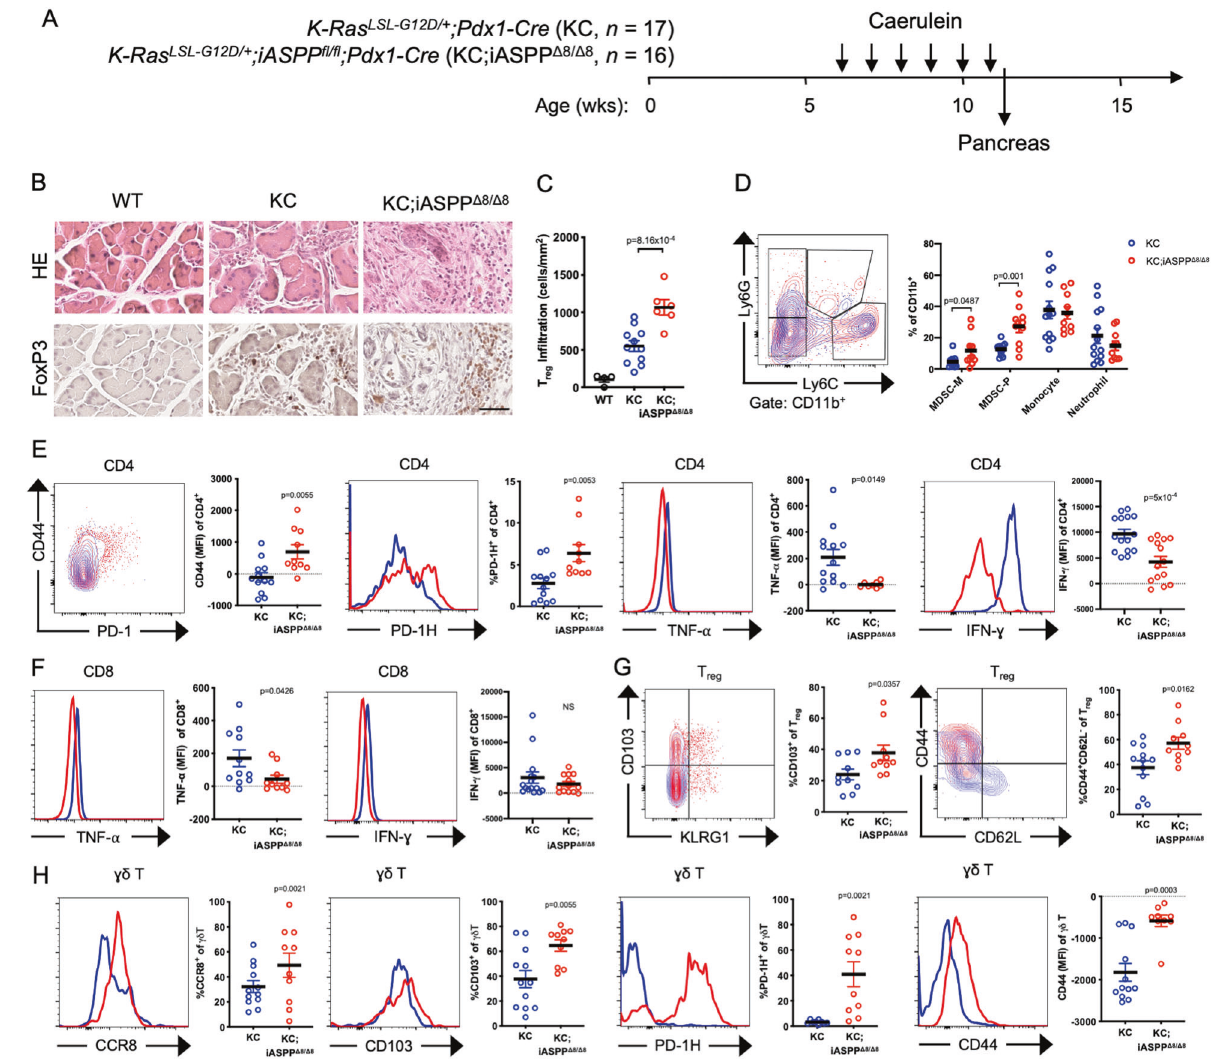
Fig. 4 Regulatory and γδ T cells in iASPP De fi cient Pancreatic Tumors Have an Activated Phenotype. A Schematic of chronic pancreatitis model and experimental design. Six-week-old WT ( n = 5), Kras LSL − G12D/ + ;Pdx1-Cre (KC, n = 17), or Kras LSL − G12D/ + ;iASPP fl / fl ;Pdx1-Cre (KC;iASPP Δ 8/ Δ 8 n = 16) mice received six weekly doses of caerulein. Mice were sacri fi ced 48 h after the fi nal dose and pancreata were collected for analysis. B HE, CD3, and FoxP3 immunohistochemistry stains of pancreata following six weekly doses of caerulein. Scale, 250 μ m. C Column scatter plot shows quanti fi cation of FoxP3 + T reg cells per neoplasia area. D Flow cytometry contour plot (left) and quanti fi cation (right) of gating strategy to identify MDSC-M, MDSC-P, monocytes, and neutrophils from KC (blue) or KC;iASPP Δ 8/ Δ 8 (red) pancreata. E Flow cytometry plots (left) and quanti fi cation (right) of CD44, PD-1H, TNF- α , and IFN- γ expression in pancreata-in fi ltrating CD4 + cells from KC (blue) or KC;iASPP Δ 8/ Δ 8 (red) pancreata. MFI median fl uorescent intensity. F Flow cytometry histograms (left) and quanti fi cation (right) of TNF- α and IFN- γ expression in pancreata-in fi ltrating CD8 + cells from KC (blue) or KC;iASPP Δ 8/ Δ 8 (red) pancreata. MFI median fl uorescent intensity. G Flow cytometry contour plots (left) and quanti fi cation (right) of CD103, KLRG1, CD44 and CD62L expression in pancreata-in fi ltrating T reg cells from KC (blue) or KC;iASPP Δ 8/ Δ 8 (red) pancreata. MFI median fl uorescent intensity. H Flow cytometry histograms of CCR8, CD103, PD-1H, and CD44 expression in pancreata-in fi ltrating γδ T cells from KC (blue) or KC;iASPP Δ 8/ Δ 8 (red)